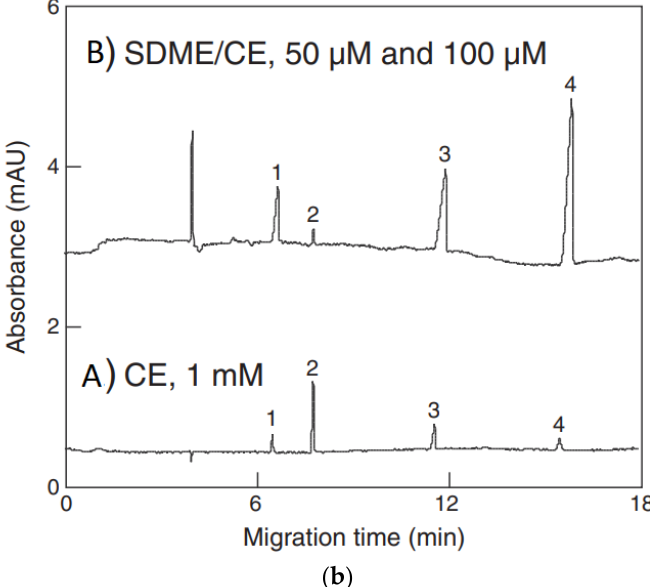
Figure 2. Application of a single drop microextraction (SDME) procedure ( a ) for inorganic arsenic species in water by CE and recorded example electropherograms ( b ) [32]. In ( a ): (1) acceptor injection, (2) organic injection (trioctylmethylammonium chloride, aliquat 336 in octanol), (3) drop formation, (4) extraction, (5) sample injection, and (6) separation. In ( b ): ( A ) CE of 1 mM arsenic compounds, ( B ) SDME/CE of 100 μ M of DMA and As(III) and 50 μ M MMA and As(V) in unbuffered water (5 min SDME). Arsenic compounds: DMA (1), As(III) (2), MMA (3), and As(V) (4). CE conditions: capillary—60 cm (50 cm), 25 μ m I.D., BGE—15 mM phosphate buffer at pH 10.6, V: +20 kV, UV detection at 200 nm, hydrodynamic injection for 5 s at 0.5 psi. (Reproduced under permission from Elsevier. License Number 5173111119111).